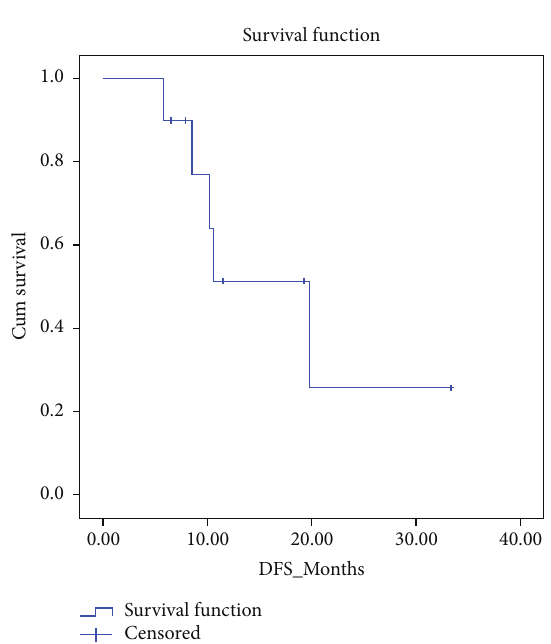
Figure 1: Kaplan-Meier figure for overall survival (OS) of all patients.